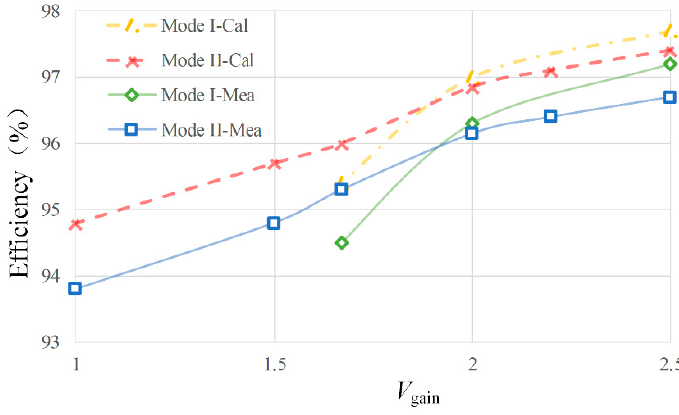
Figure 18. E ffi ciency curves of di ff erent modes at the rated power. Figure 18. Efficiency curves of different modes at the rated power. Figure 18. Efficiency curves of different modes at the rated power.